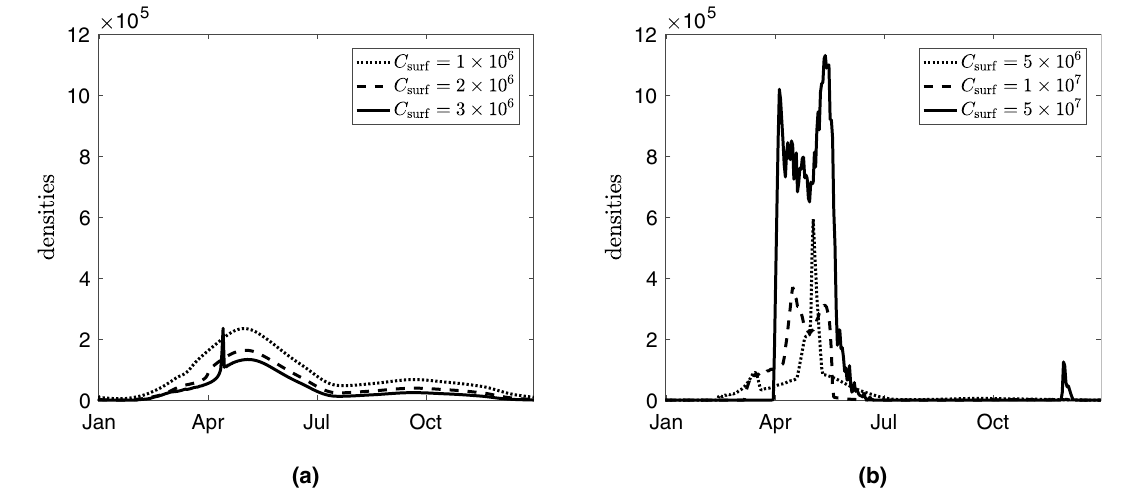
Figure 6. Daily average densities of susceptible bacteria S within the upper 20 cm of the soil calculated for different values of carrying capacity C surf (Nakhon Phanom province): The corresponding values of C surf (measured in cell/ml) are provided in figures: ( a ) C = 3 × 10 6 cell / ml . ( b ) highly enriched environment, C surf C = 5 × 10 7 cell / ml . The unit of the density of S is surf